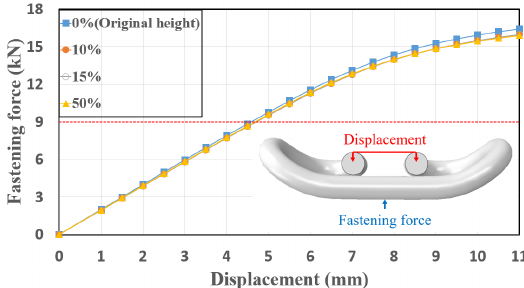
Figure 6. Fastening force vs. displacement diagram varying the spring end height difference.